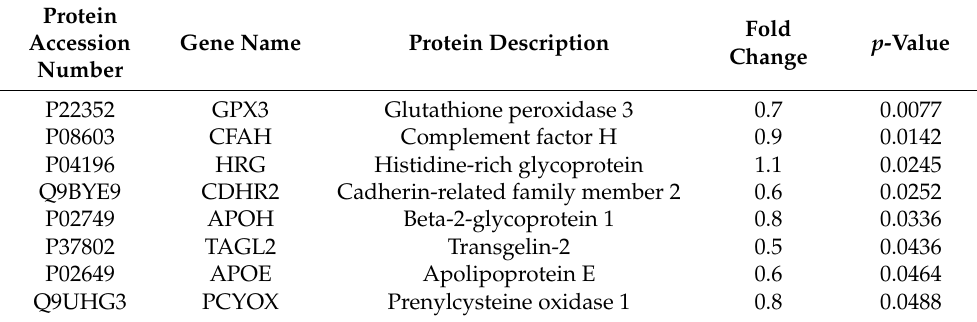
Table 1. Statistically significant de-regulated proteins between PRGF vs PRGF